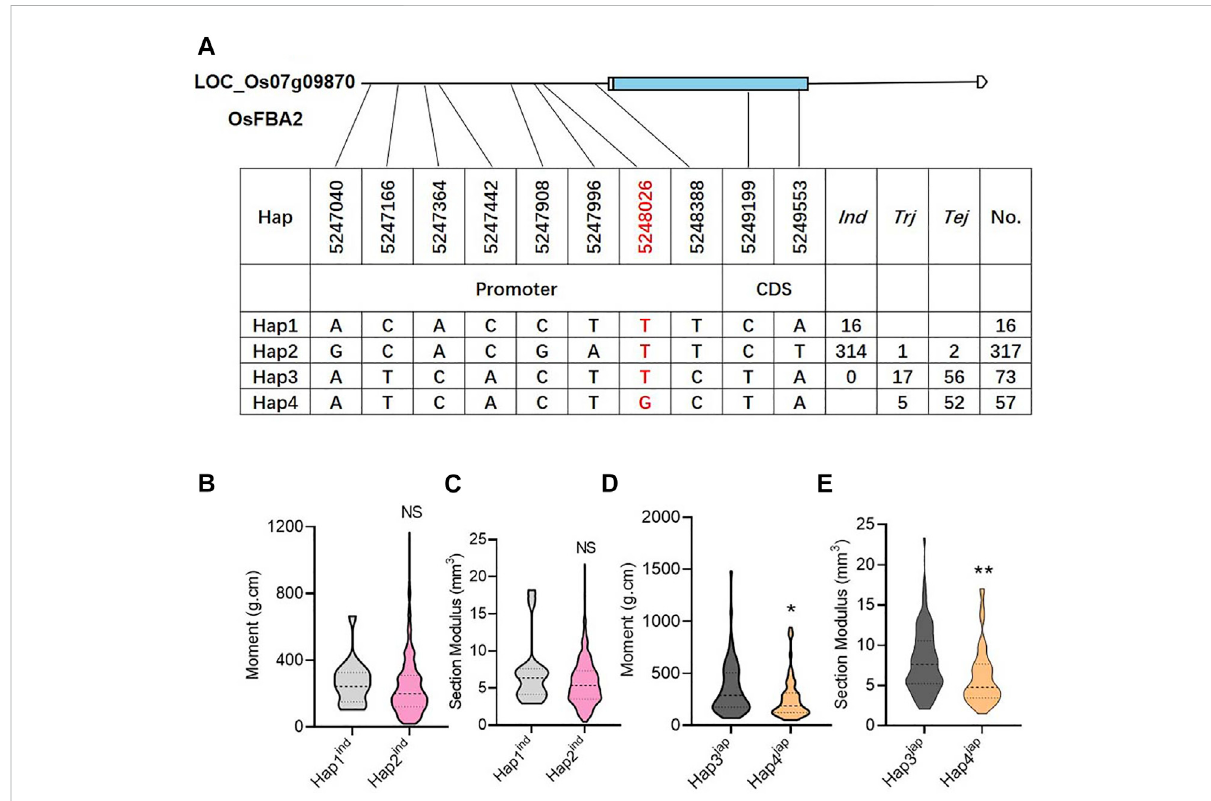
FIGURE 5 Haplotype identi fi cation of OsFBA2 . (A) Candidate genomic region and haplotypes of OsFBA2 from 463 rice cultivars, where Tej ; temperate japonica population, Trj ; tropical japonica population, Ind ; indica population. (B – E) Phenotypic variation comparison among various haplotypes for bending moment at breaking (B,D) , section modules (C,E) . NS; no signi fi cant difference, * p < 0.05, ** p < 0.01 based on two-tailed Student ’